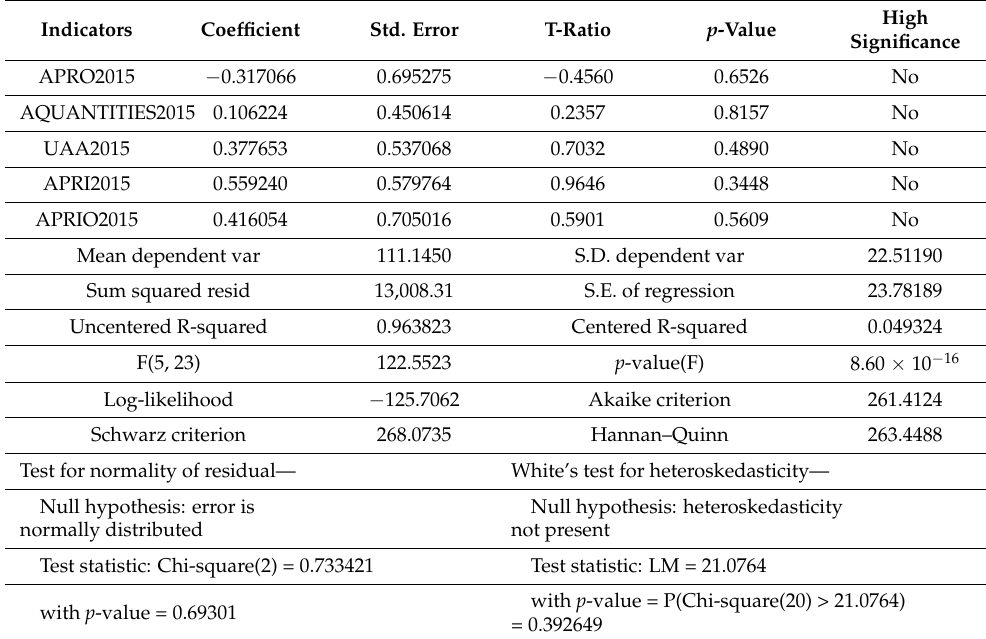
Table 5. Model 2015: OLS, using observations 1–28 (Dependent variable: